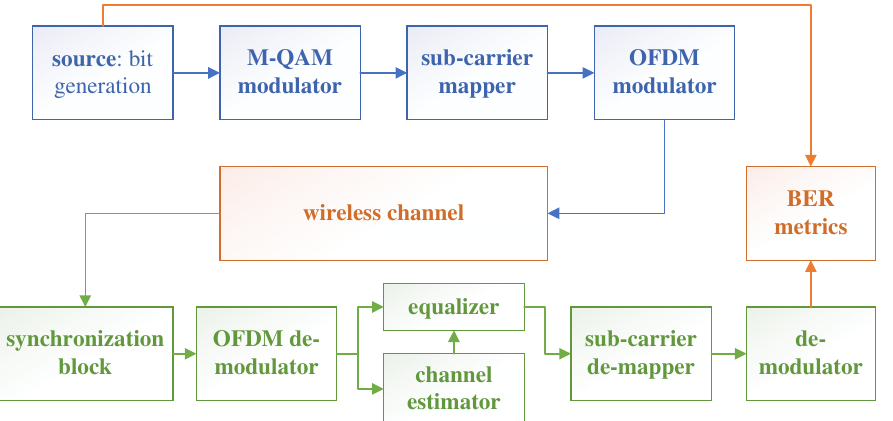
Figure 1. Functional blocks of the simulator. Blocks related to the transmitter are drawn in blue whereas blocks related to the receiver are drawn in green. Blocks related to Bit Error Rate (BER) metric computation and wireless channel are in